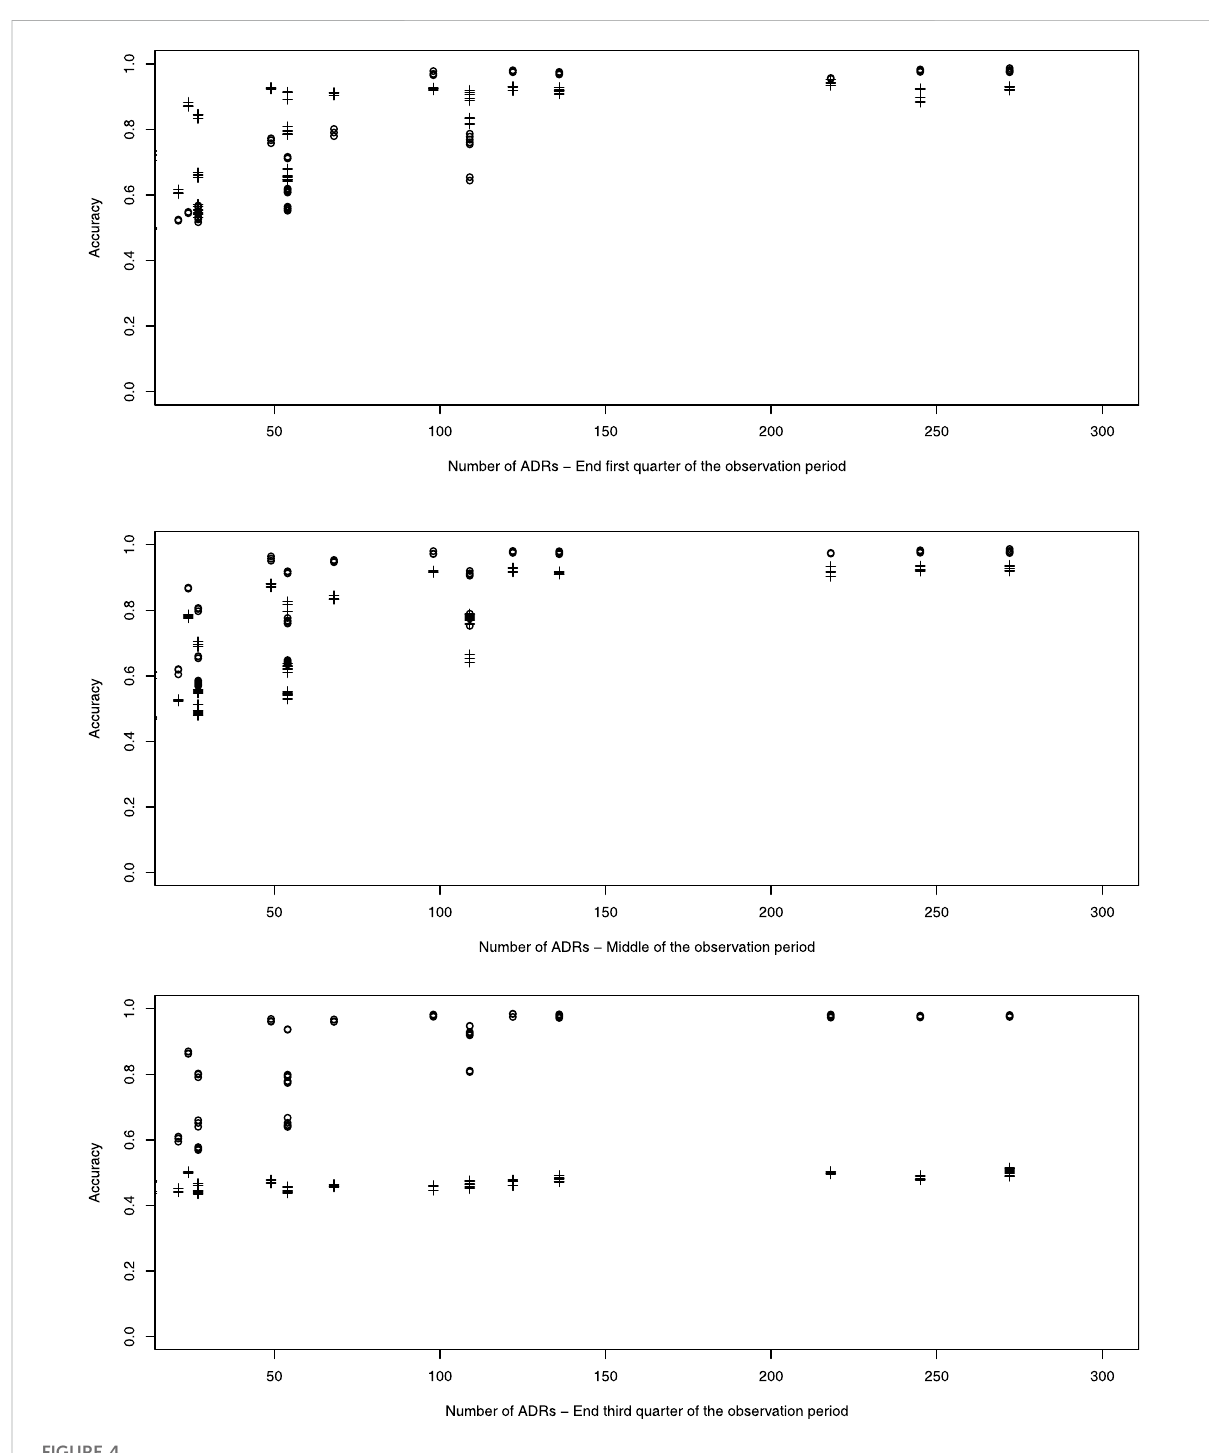
FIGURE 4 Plot of accuracy against the number of simulated ADRs. dWSP: +; pWSP: